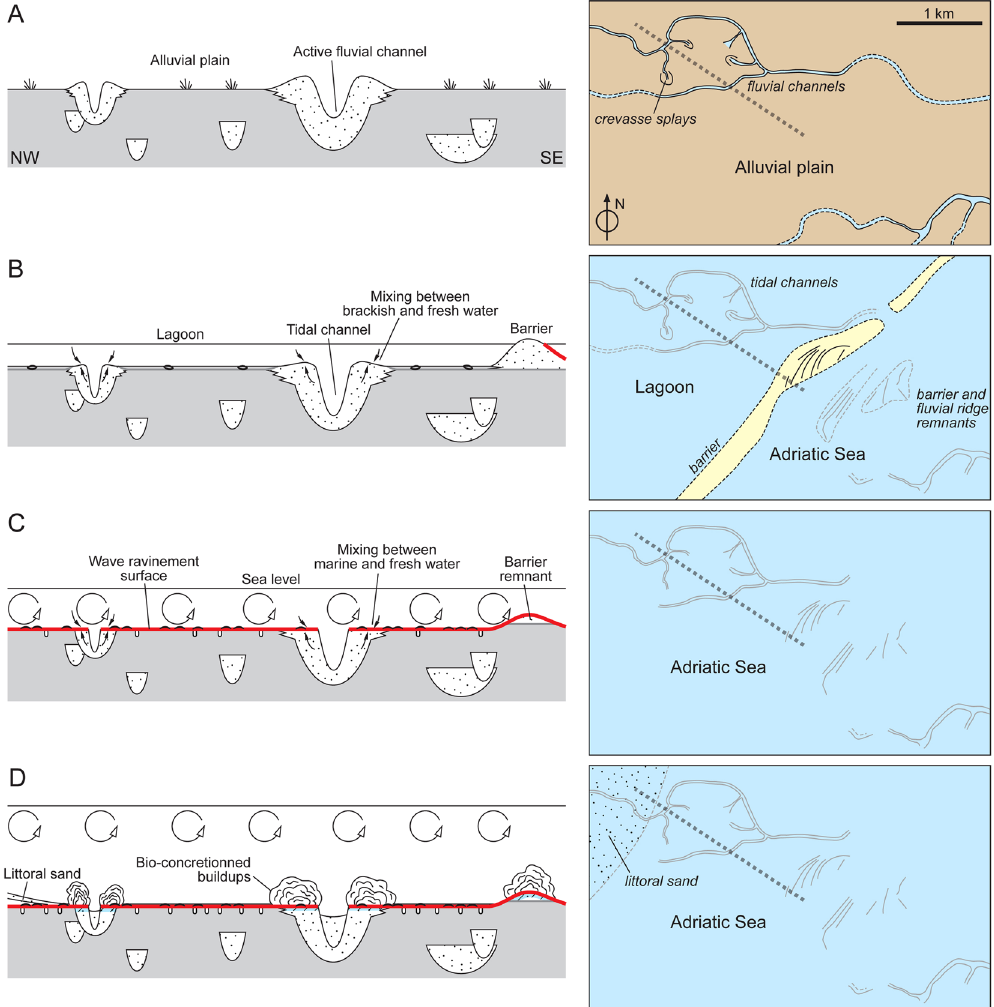
Figure 6. Genetic model of coralligenous buildups within the geological evolution framework of the Venice offshore. The trace of the area covered by the sketch is provided in Fig. 1, red rectangle. Dashed grey lines show the position of the profiles. ( A ) Fluvial ridges developed on the LGM alluvial plain. ( B ) The study area was temporarily transformed in a lagoon protected seaward by a barrier island during the post-LGM transgression. ( C ) The lagoon was rapidly overstepped due to the eustatic sea-level rise and wave action produced a wave- ravinement surface. ( D ) The cementation of the previously deposited sandy sediments, induced by the mixing between marine and fresh water, led to formation of stable substrates that favored the growth of bio- concretionned